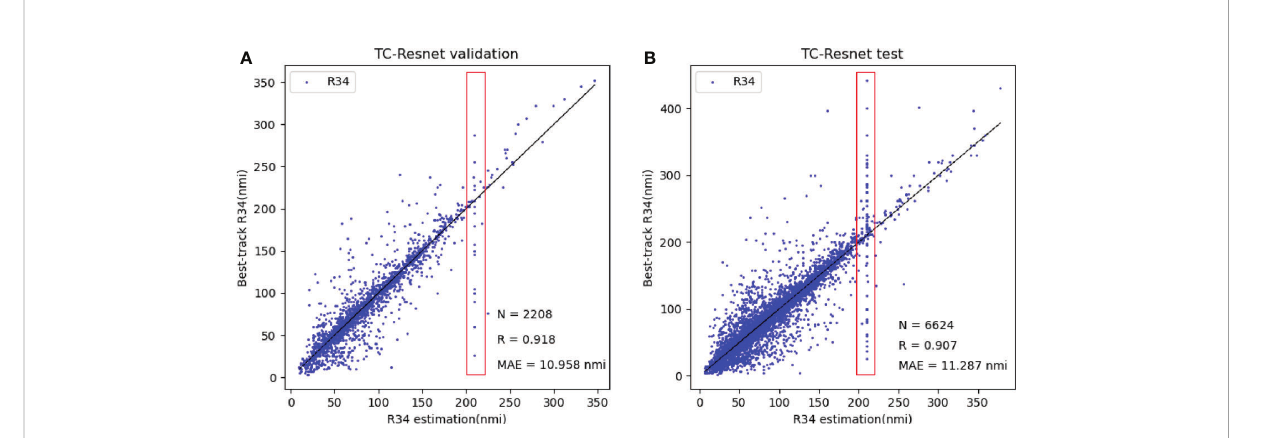
FIGURE 8 Scatter plot of model results on the (A) validation and (B) test